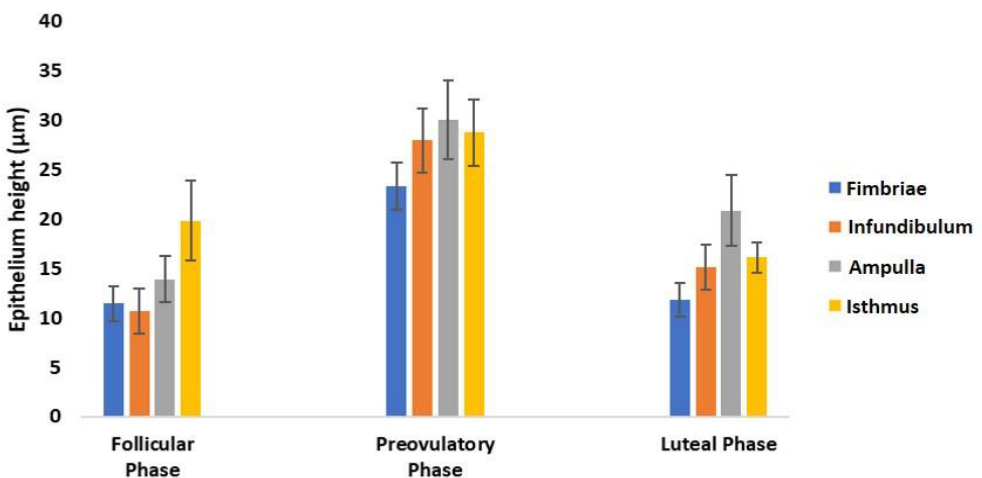
Figure 7. Height of the oviductal epithelium of the baboon Papio hamadryas during the menstrual